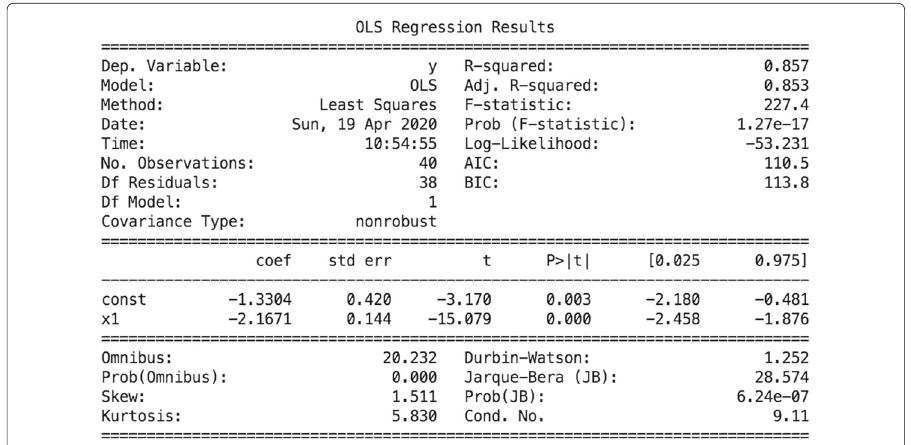
Fig. 7 Ordinary least-squares (OLS) regression outputs for the log-transformed variables plot in Fig. 6. The negative power law coefficient for the degree distribution was found to be 2.1671 and is highly